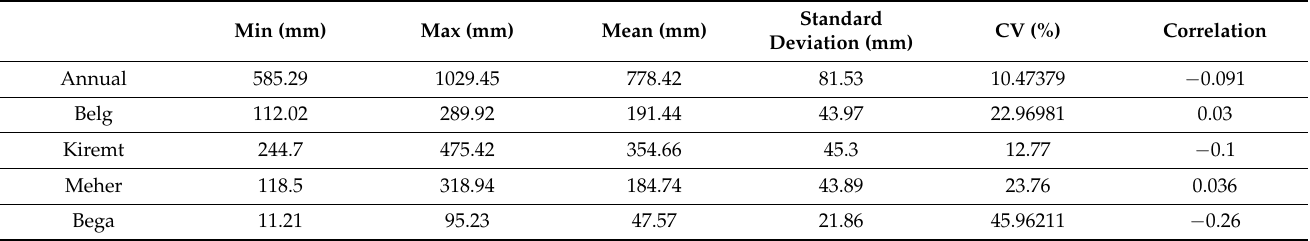
Table 1. Mann–Kendall and Sen’s test for precipitation data of Ethiopia (1958–2020) [63,64].